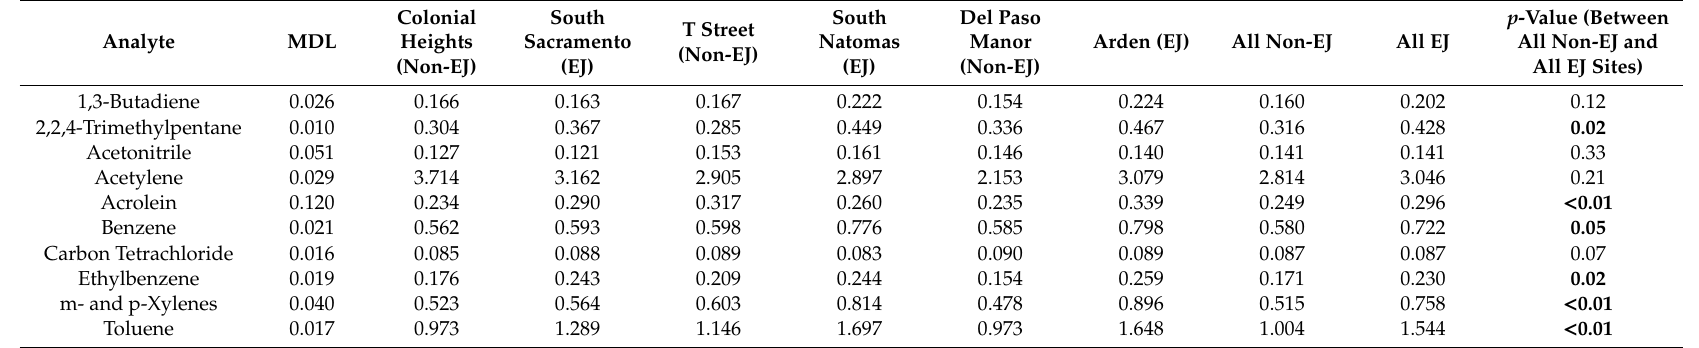
Table 4. MDL and site concentrations ( µ g / m 3 ) for each HAP, and p-value of significance between all EJ and non-EJ sites. Bold indicates significant di ff erences at the 95% confidence level used by the Mann–Whitney U-test. Sites are ordered by non-EJ / EJ